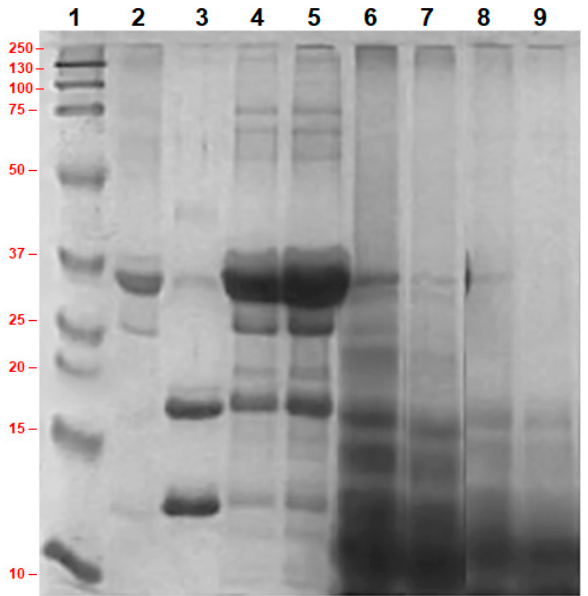
Figure 6. Sodium dodecyl sulfate polyacrylamide gel electrophoresis (SDS-PAGE) image of ultra-heat-treated skimmed milk, milk with concentrated proteins and milk with concentrated proteins after enzyme treatment; lane 1: marker protein, lane 2: standard casein, lane 3: standard α -lactalbumin and β -lactoglobulin, lane 4: ultra-heat-treated skimmed milk, lane 5: concentrated ultra-heat-treated skimmed milk, lane 6: concentrated liquid milk protein treated with 0.008 g L − 1 of trypsin, lane 7: concentrated liquid milk protein treated with 0.016 g L − 1 of trypsin, lane 8:concentrated liquid milk protein treated with 0.032 g L − 1 of trypsin, lane 9: concentrated liquid milk protein treated with 0.064 g L − 1 of trypsin.